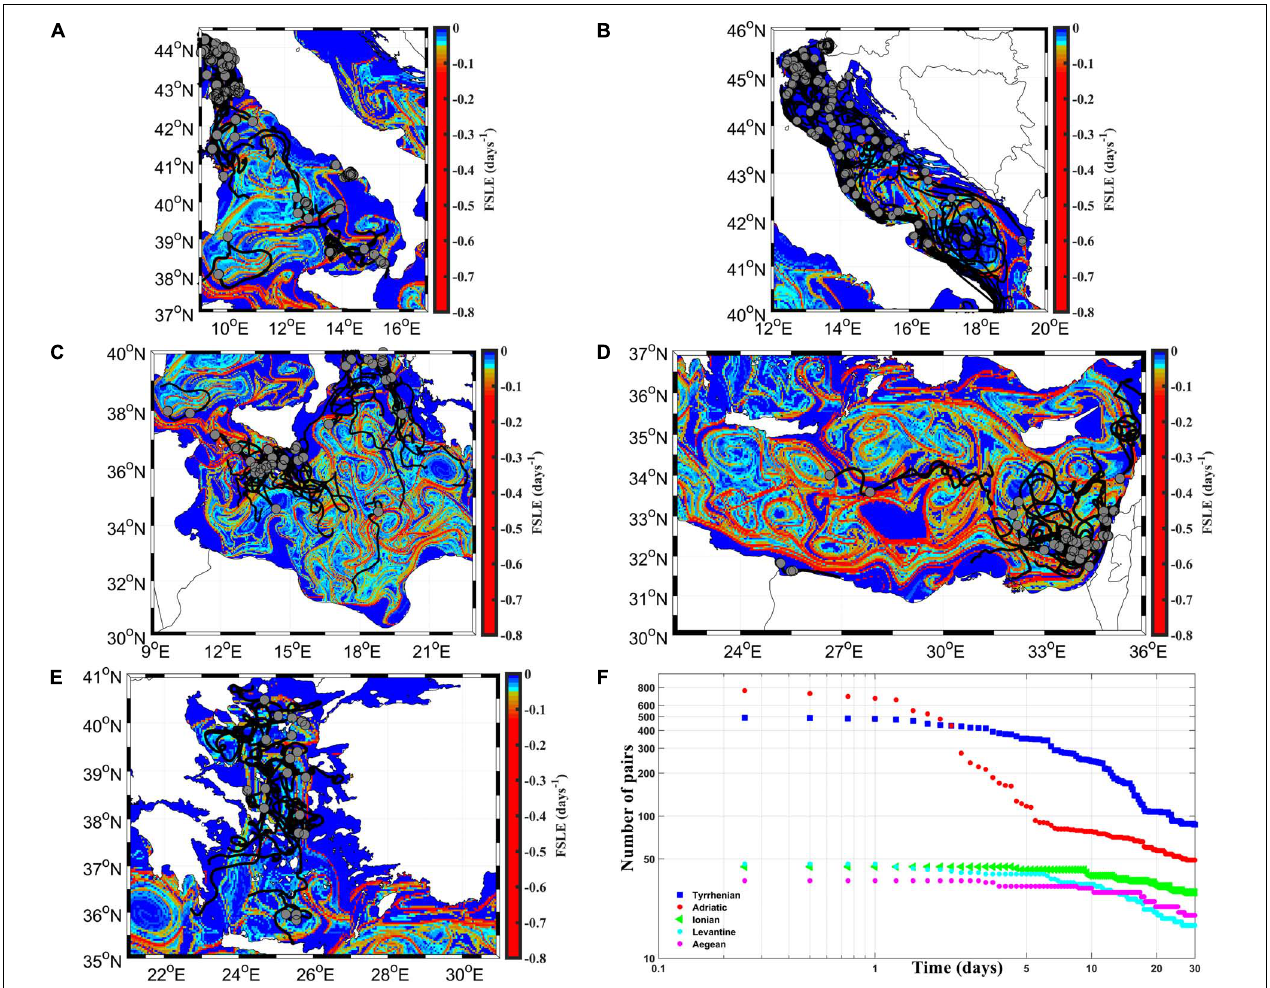
FIGURE 3 | The spatial distribution of the FSLE superposed with the initial pair positions (gray dots) and their trajectories (black lines) during 30 days (A) in the Tyrrhenian, (B) the Adriatic, (C) the Ionian, (D) the Levantine, and (E) the Aegean sub-basins. The number of drifter pairs as a function of time is shown in (F)